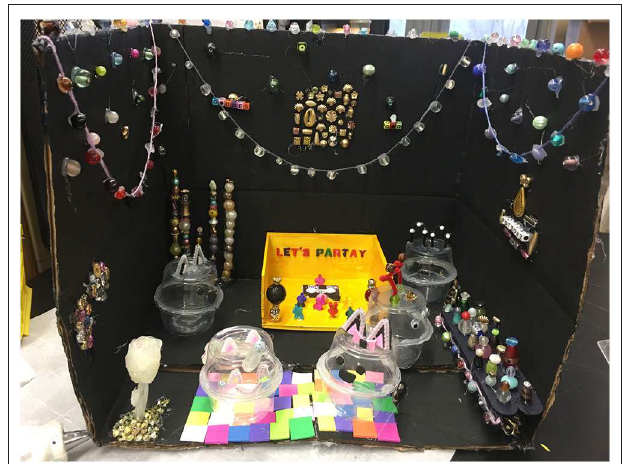
FIGURE 13 | K-Pop Dance Party.